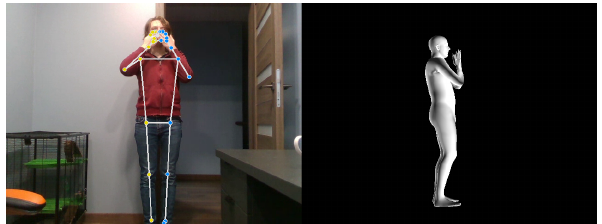
Figure 6. Subject image ( left ) and its pose reconstruction ( right ) (From top to bottom): subject leaning left, subject leaning forward, subject leaning backwards, subject leaning sideways, subject touching face.